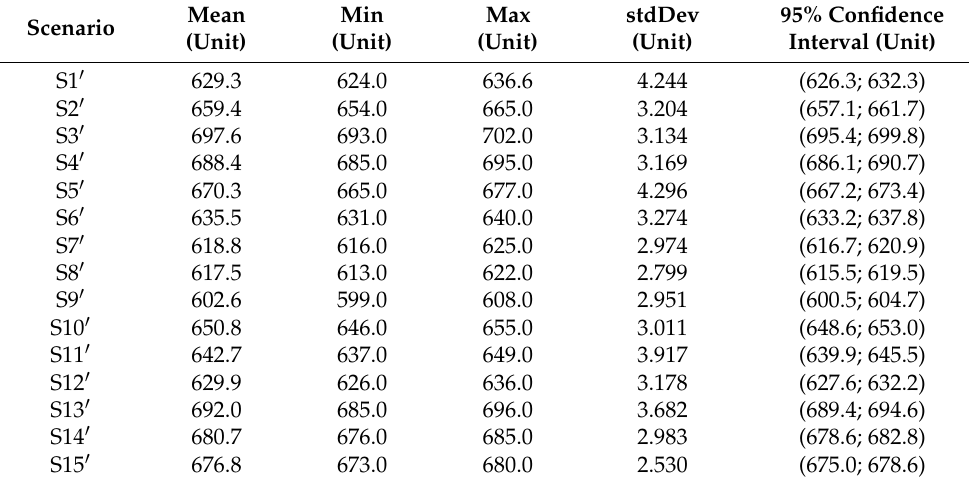
Table 5. Monthly productivity of the manufacturing system under the scenarios S1 (cid:48) –S15 (cid:48) , based on the response